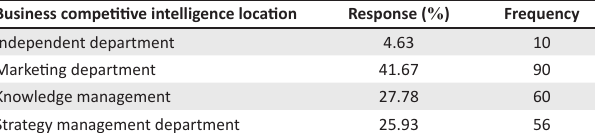
TABLE 18: Frequency of response to the location of competitive intelligence in firms in the property sector ( N =